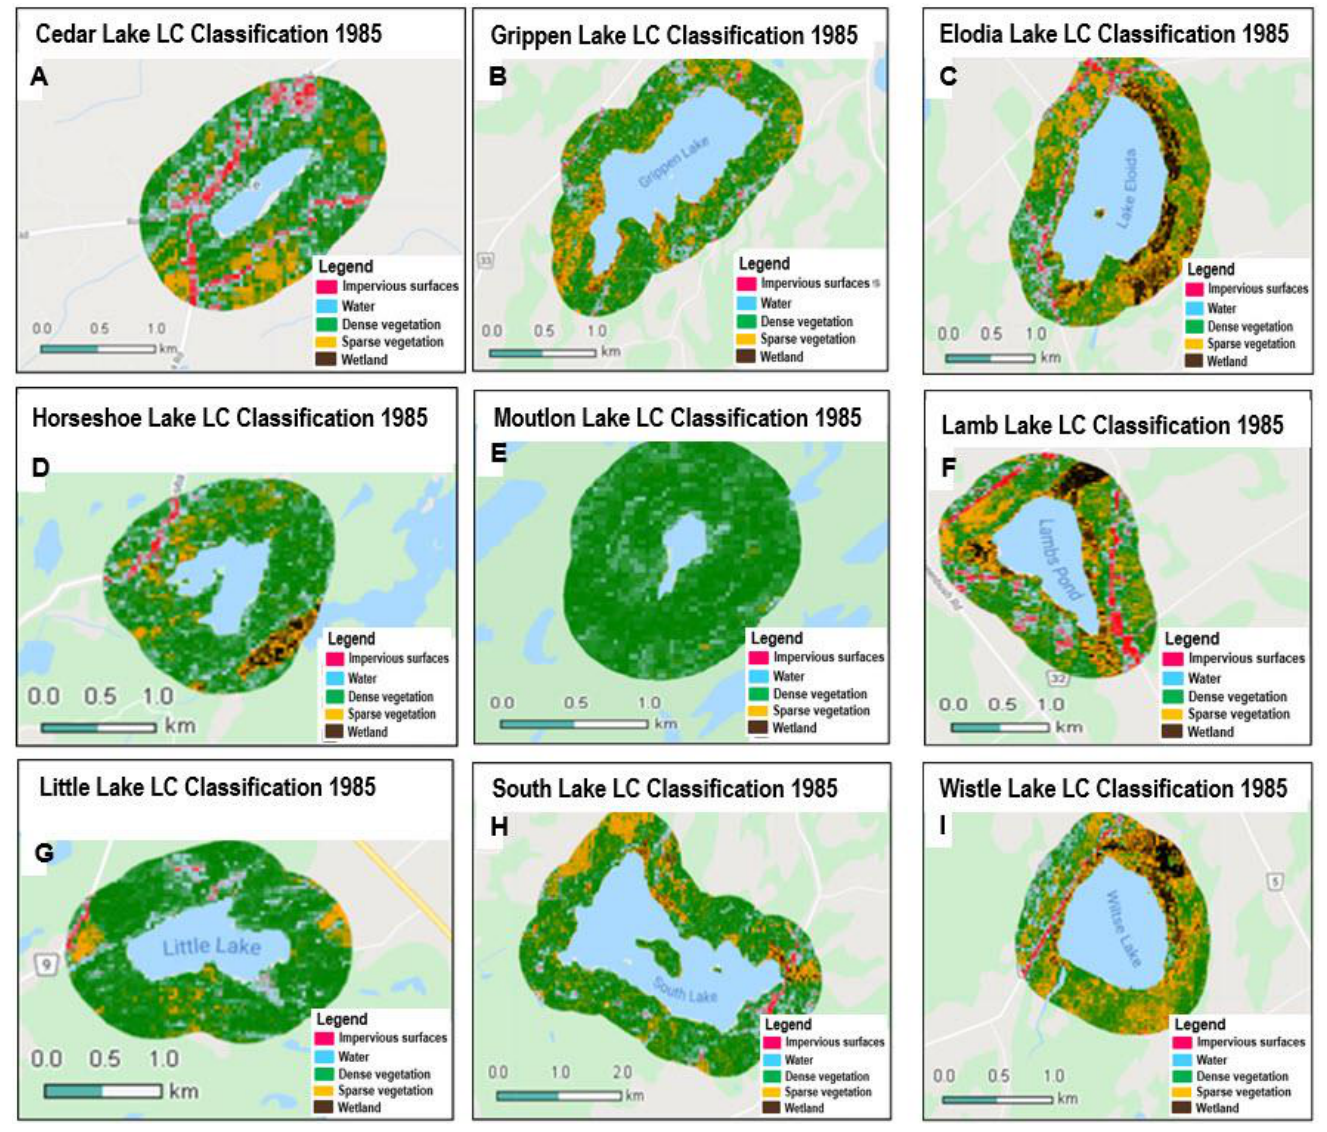
Figure 4. Land cover classification maps of nine lakes in 1985 : ( A ) Cedar Lake; ( B ) Grippen Lake; ( C ) Elodia Lake; ( D ) Horseshoe Lake; ( E ) Moutlon Lake; ( F ) Lamb Lake; ( G ) Little Lake; ( H ) South Lake; ( I ) Wistle Lake.